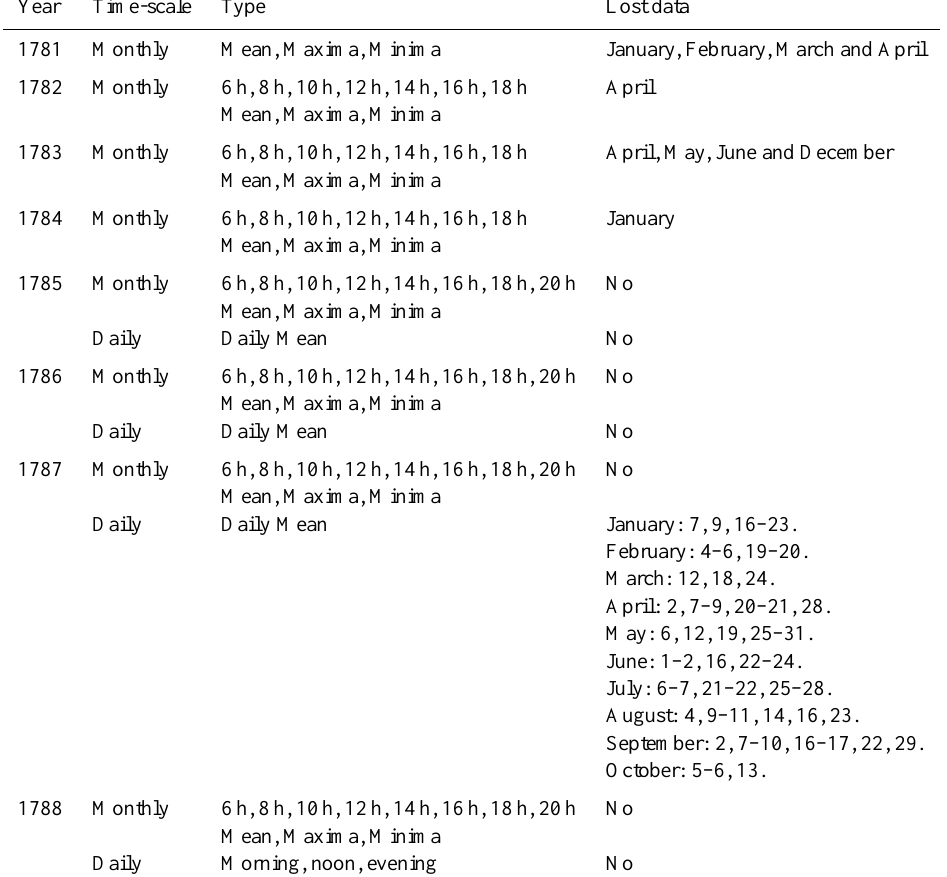
Table 1. Temporal availability of the Sanches Dorta geomagnetic data, on a year by year basis, between 1781 and